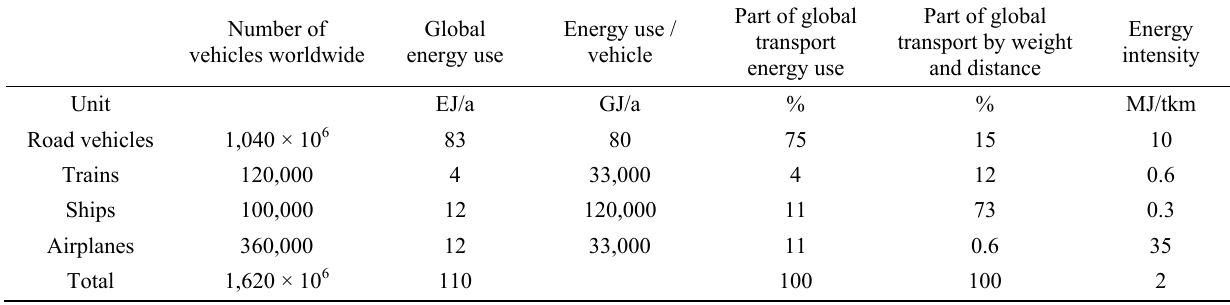
Fig. 6 Number of transportation vehicles worldwide and their global annual energy consumption and energy intensity (energy consumption per tonne weight transported and kilometre). Table 2 Key energy and energy efficiency figures in